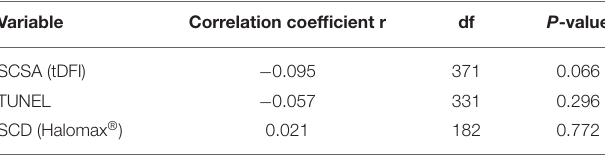
TABLE 1 | Partial correlations between sDF (SCSA, TUNEL, and SCD) and total born piglets, adjusting for the sow’s cycle. Variable